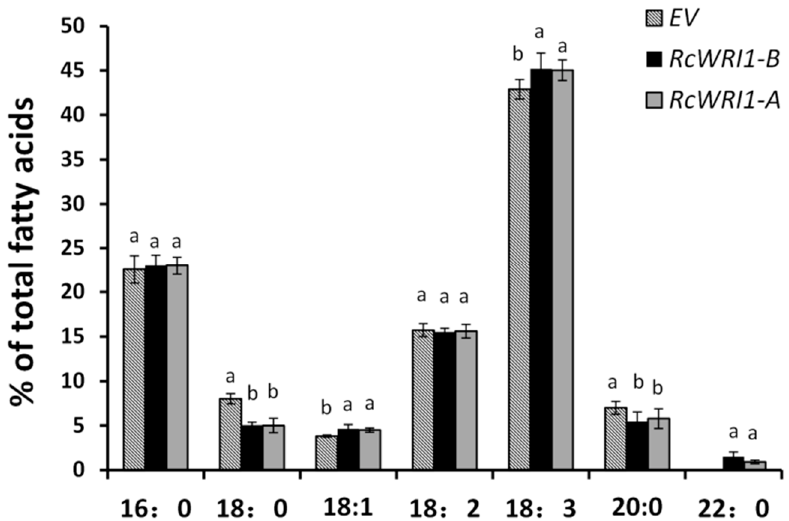
Figure 8. Fatty acid profiles in N. benthamiana leaves expressing each of RcWRI1s . Fatty acids were extracted from the leaf samples and then transmethylated, followed by gas chromatography analysis. Fatty acid content was expressed as the percentage of leaf dry weight. EV indicates empty-vector control. Each value is the mean ± SE of twelve biological replicates. Letters a, b indicate significant differences at the level p < 0.05 according to the Tukey’s test.